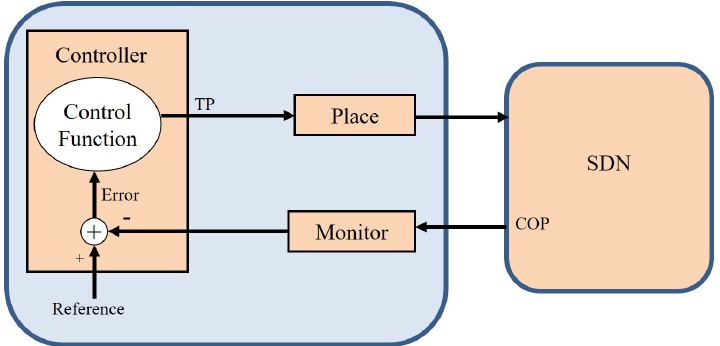
Figure 1. Block diagram for Feedback Control System for the DFBCP SDN model.